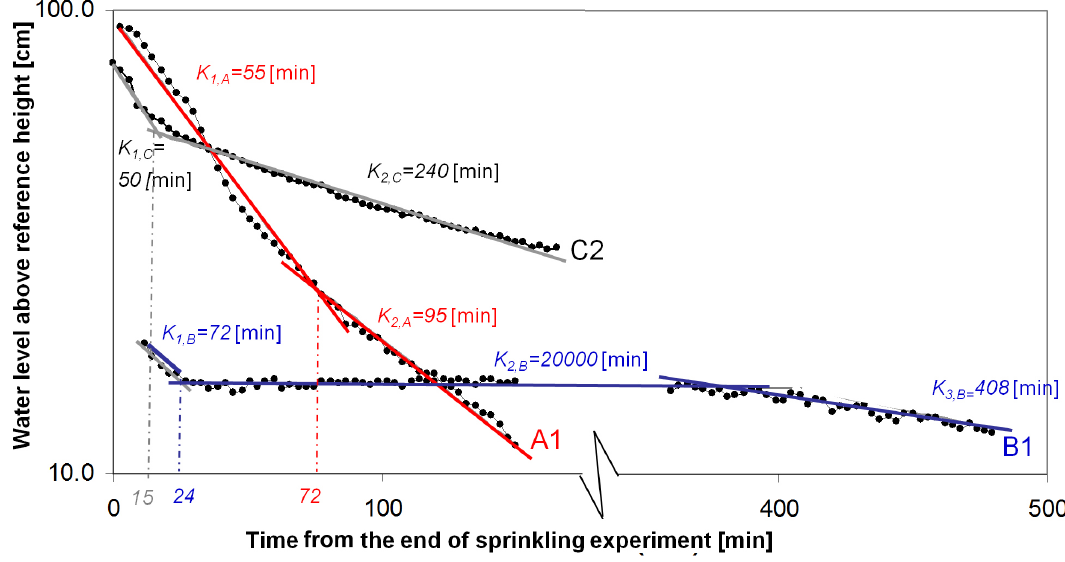
Figure 3. Drawdown curves observed in piezometers A1, B1 and C2 after the end of sprinkling experiments and corresponding depletion factors K